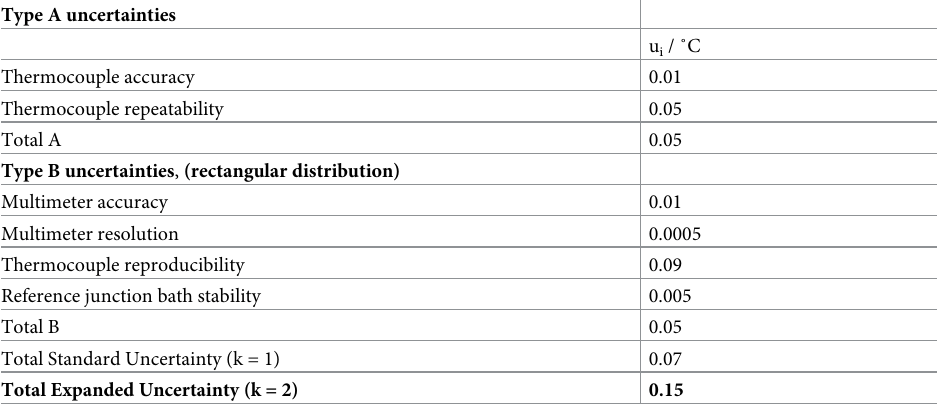
Table 2. Temperature measurement system uncertainties a